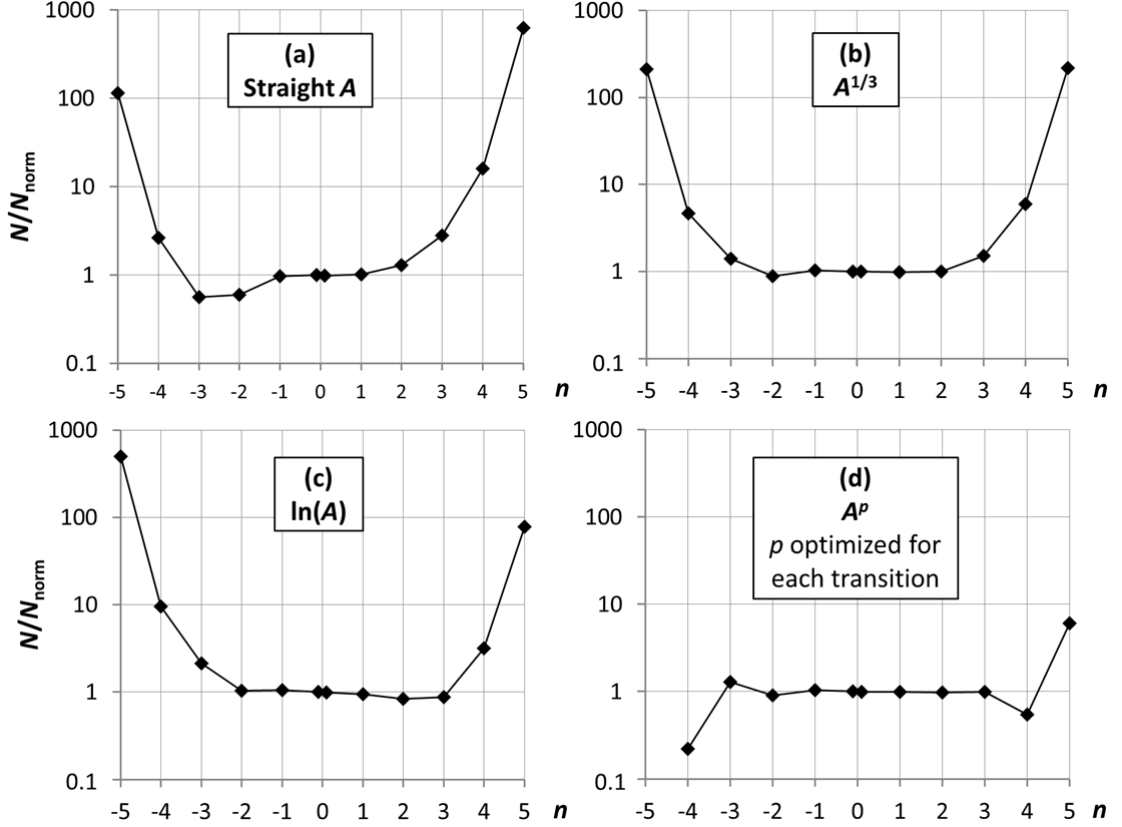
Figure 3. Ratios of fractional number of counts N ( n ) of Monte Carlo trial data to those of the normal distribution N ( n ) for three global transition-rate functions, ( a ) straight A norm ( f = A ); ( b ) power of 1/3 ( f = A 1/3 ); and ( c ) logarithm ( f = ln( A )) for all 590 M1 and E2 transitions of Fe V; Panel ( d ) shows the same ratios for f = A p , where p is optimized individually for each